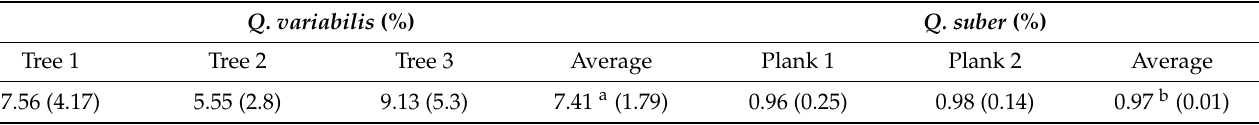
Table 3. Latecork percentage in Q. variabilis virgin cork and Q. suber reproduction cork. Q. variabilis (%)